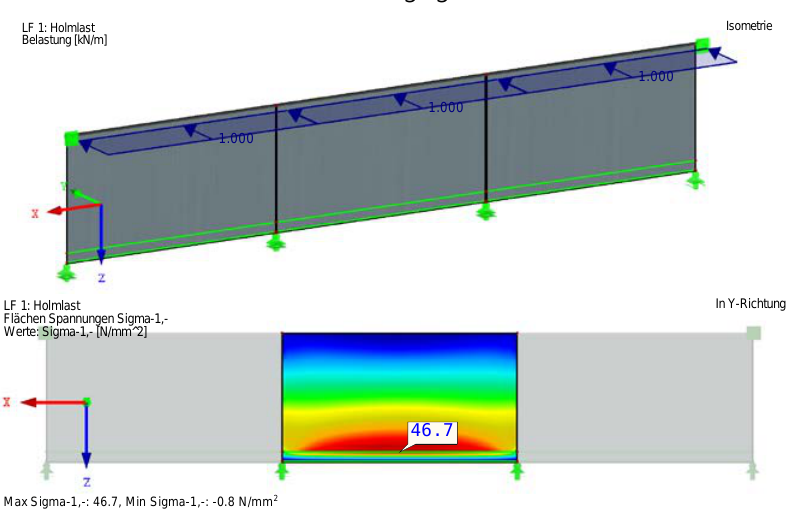
Fig. 10 Stress determination by modelling the entire railing system with Dlubal RFEM®